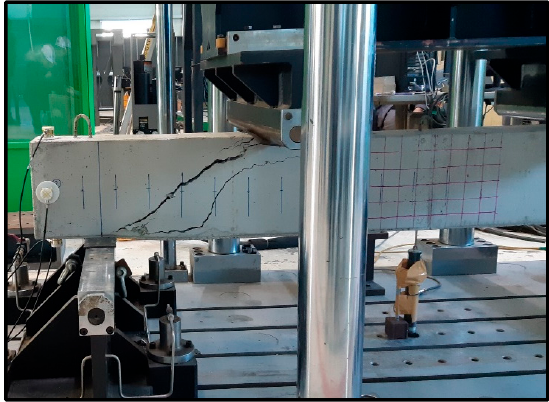
Figure 8. Macro-cracks/fractures taking place after the application of a gradually increasing load.